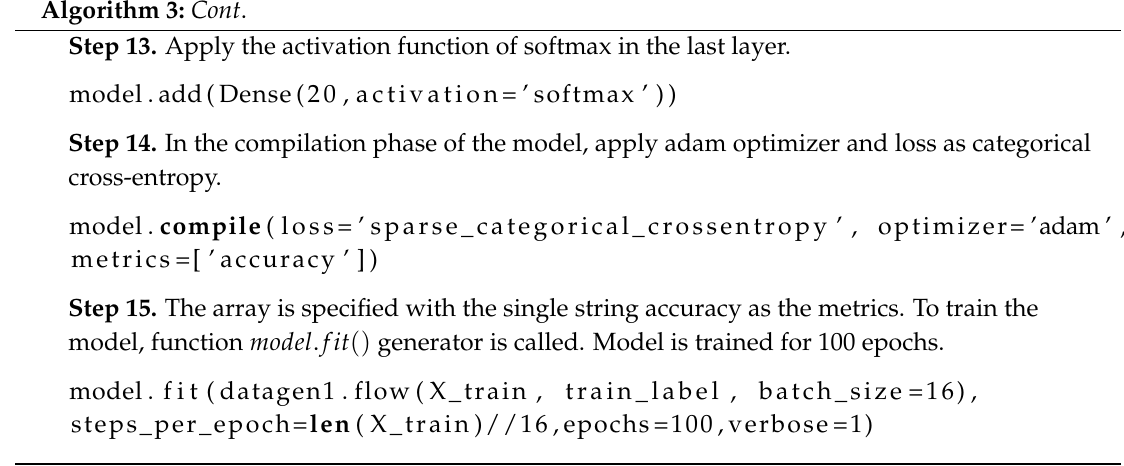
Algorithm 3: Cont .